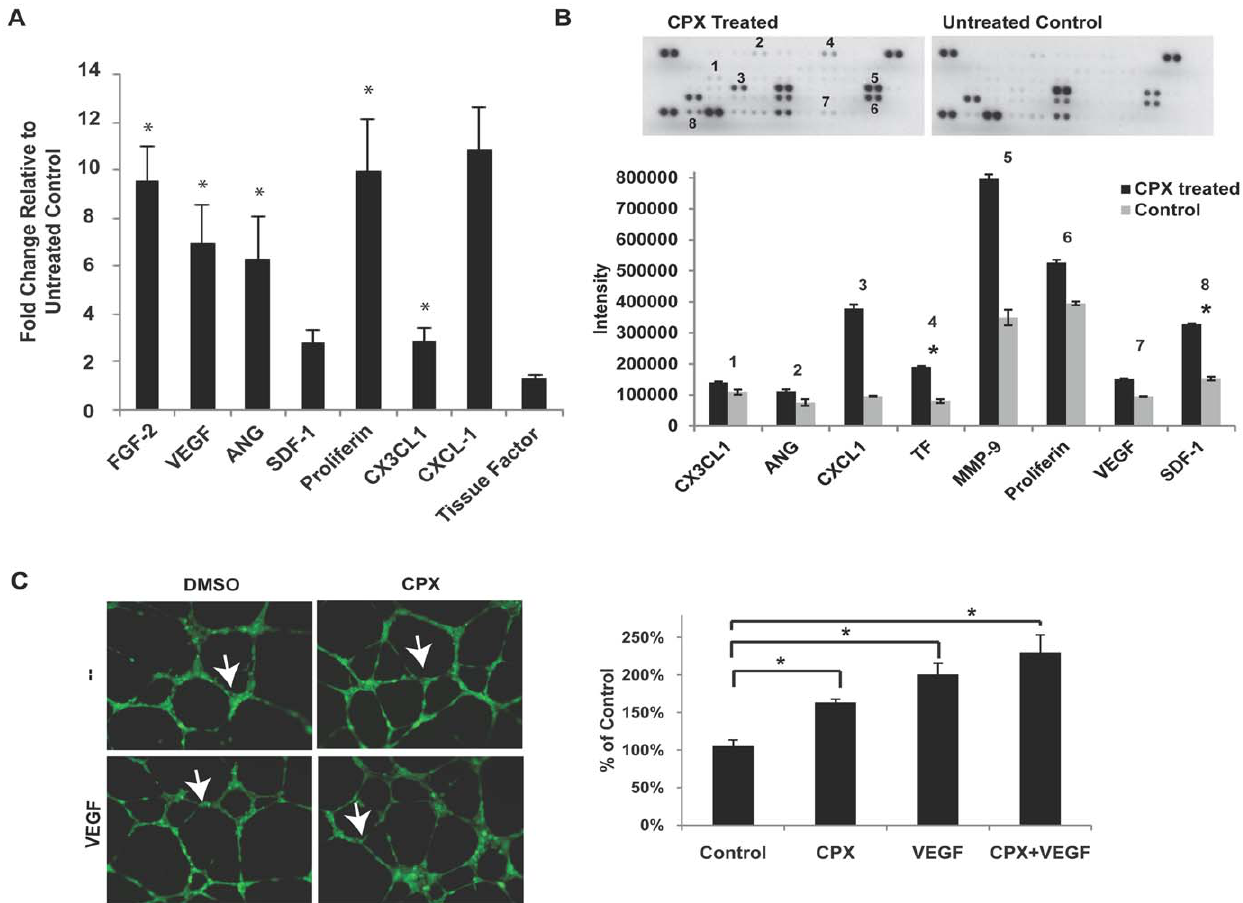
Figure 2. Downstream effects of CPX treatment invitro . ( A ) QRT-PCR analysis on NIH3T3 cells treated with 10 m M CPX for 24 hours versus untreated control. There were 3 to10-fold increases in the mRNA expression of multiple angiogenesis-related genes relative to that of untreated control cells. Asterisks indicate *p , 0.05. ( B ) Angiogenesis antibody array using condition media from NIH3T3 cells treated with 10 m M CPX for 24 hours versus condition media from untreated control cells. Membrane images of antibody array treated with condition media of treated and control cells (top). Specific proteins captured on the array are labeled 1 to 8. Semi-quantitative profiles of proteins 1 to 8 on the angiogenesis antibody array using reverse image scanning densitometry (bottom). There was a significant increase in the expression of multiple angiogenic proteins by NIH3T3 cells treated with CPX compared to untreated control cells. Asterisks indicate *p , 0.05. ( C ) The ability of CPX (10 m M) in inducing in vitro tubule formation with or without VEGF (10 ng/ml) treatment. Representative cell images showing field of view as indicated (left). The angiogenic effect was quantified by counting the number of branch points per field of view (right). Endothelial cells treated with CPX (10 m M) increased the number of branch point cells with or without concomitant VEGF (10 ng/ml) treatment compared to those cells treated with DMSO control (40X). White arrows indicate examples of branch points (*p , 0.05).